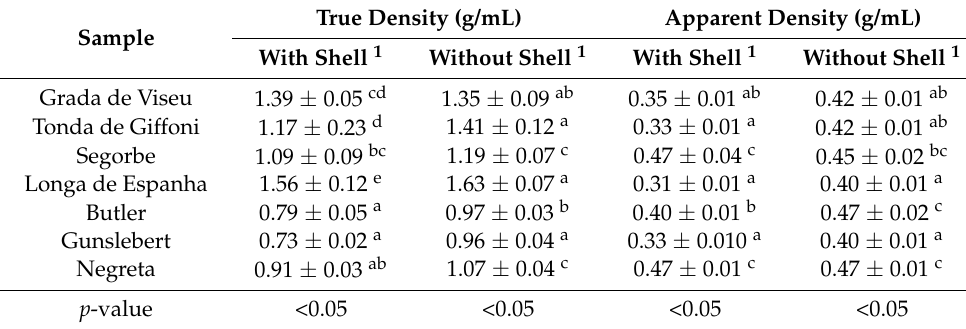
Table 3. Hazelnuts’ density (mean ± standard deviation).